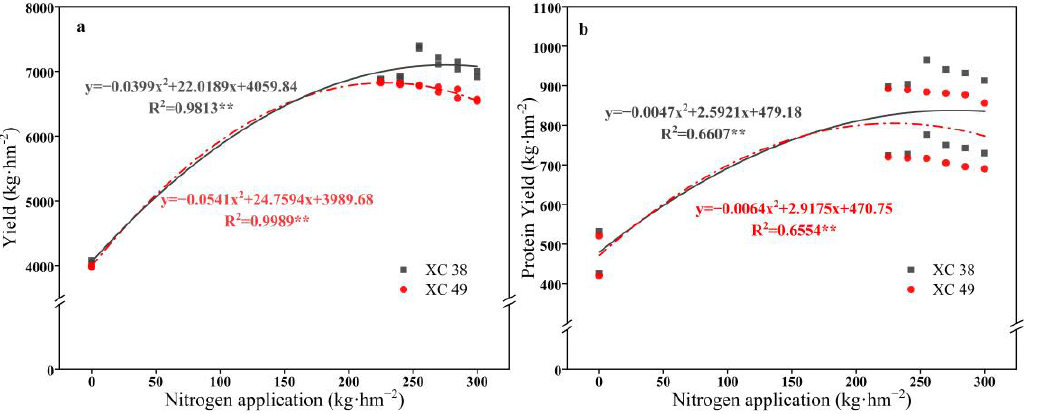
Figure 7. Response of yield and protein yield of XC 38 and XC 49 to nitrogen fertilizer. ( a ) Response of yield to nitrogen fertilizer; ( b ) Response of protein yield to nitrogen fertilizer. XC 38: Xinchun 38; XC 49: Xinchun 49. “**” indicates significant difference at 0.01 level.